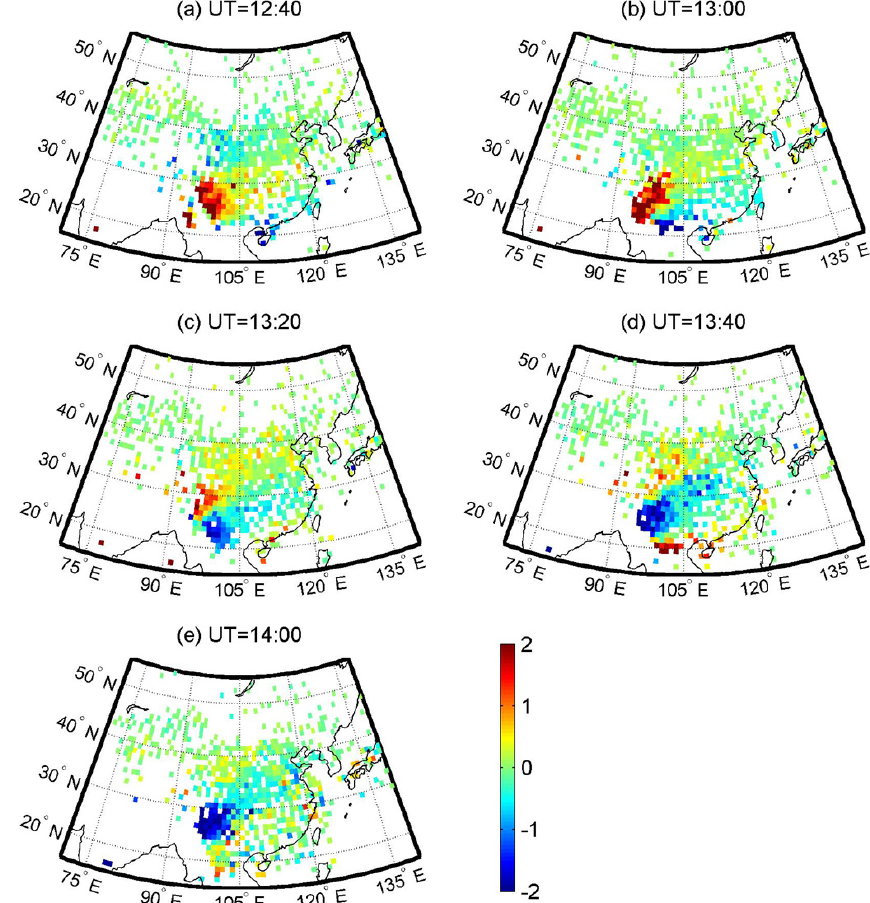
Fig. 4. As for Fig. 3, but for 12:40–14:00UT (i.e., 20:40–22:00LT).